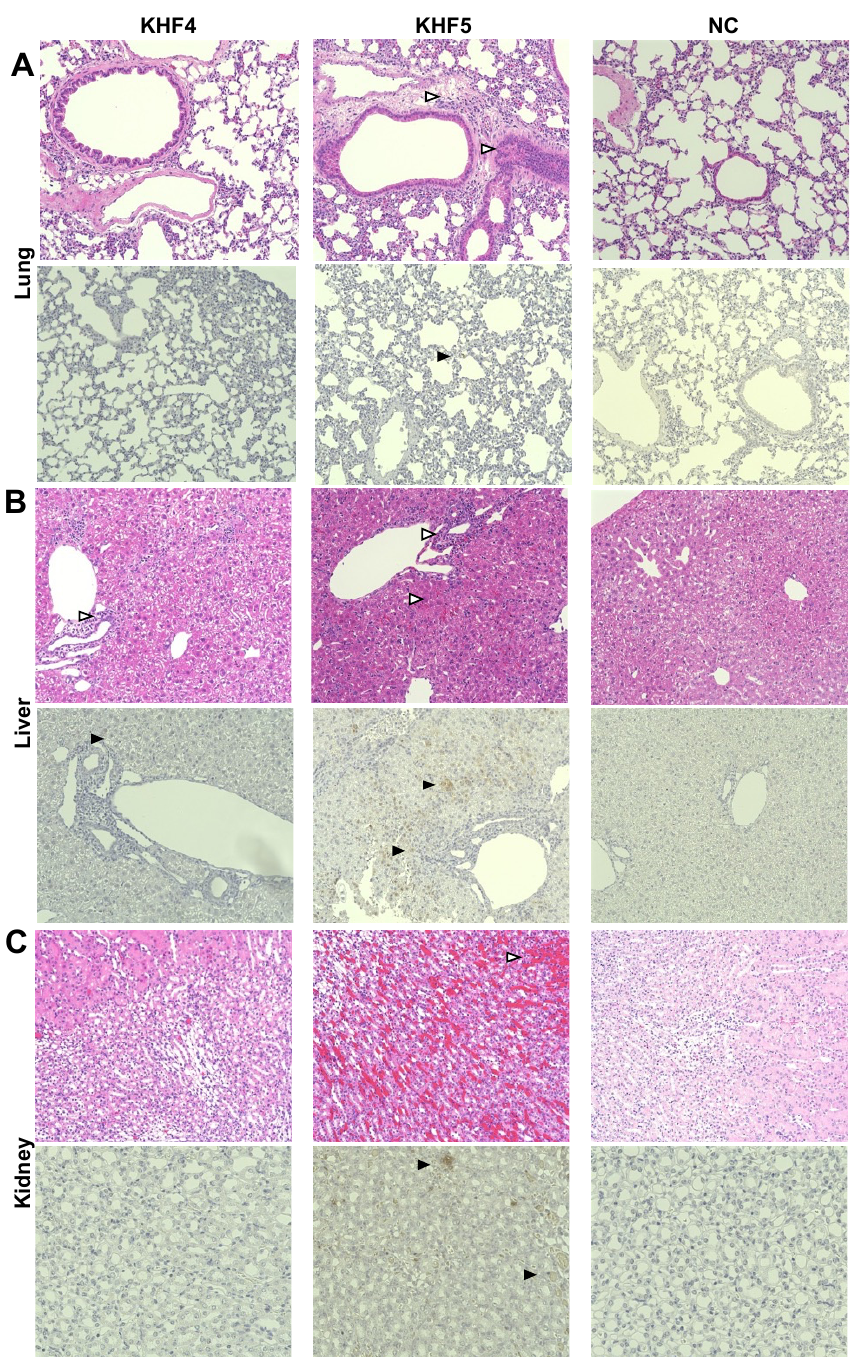
Figure 6. Immunohistochemistry analysis of tissues from KHF4 and KHF5-infected mice. Tissue slices were stained with hematoxylin and eosin (HE), and viral antigens were detected using a biotinylated E5G6 monoclonal antibody with the Vector M.O.M immunodetection kit. Characteristic lesions were indicated by open triangles. Viral antigens are indicated by closed triangles. ( A ) Peri bronchus edema with lymphocyte aggregation was observed in KHF5-infected lungs, and mild antigen reaction was observed in KHF5-infected alveolar epithelial cells. ( B ) Petechial hemorrhage was observed in KHF5-infected livers by HE staining, whereas KHF5-infected livers showed multiple antigenic reactions and hemorrhage. The KHF4-infected liver also showed perivascular lymphoid infiltration. ( C ) Renal hemorrhage caused by KHF5 infection was distributed in the cortex-medullary region, and antigens were detected in the tubular regions.